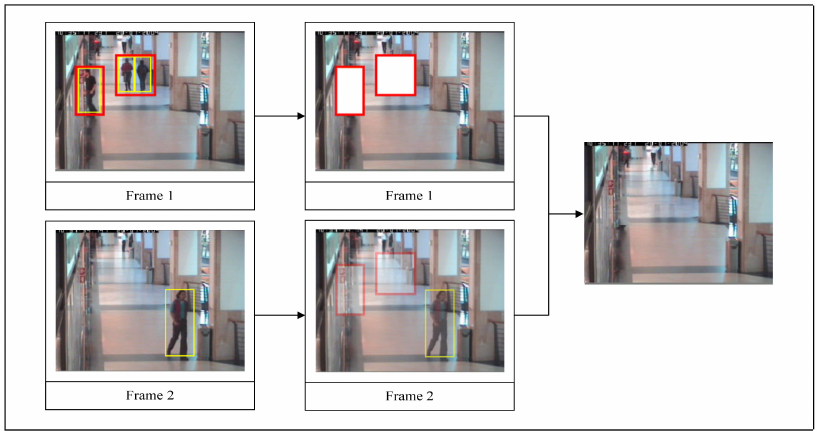
Figure 5. Makeup of the background in the first labeled